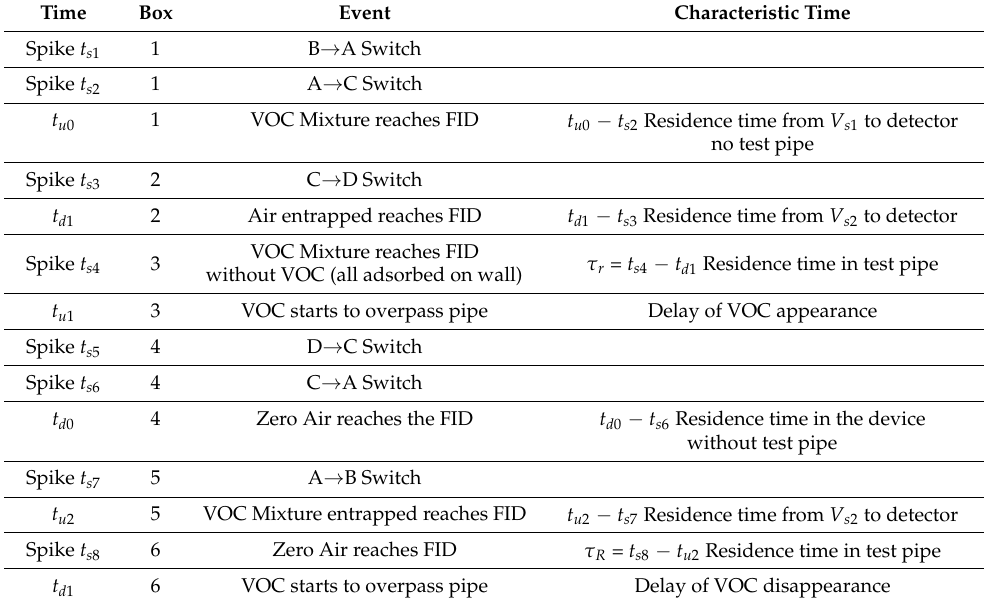
Table 2. Correspondence of signal times with residence/contact times, box refers to Figure